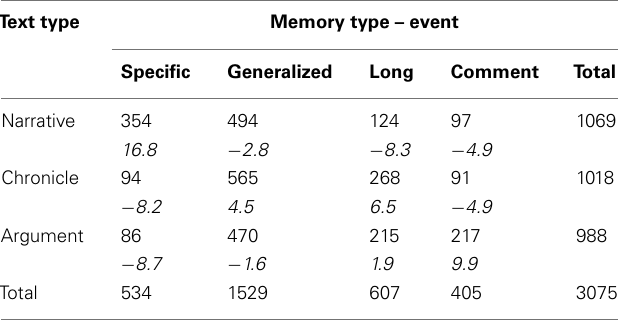
Table 2 | Crosstabulation of text type with memory